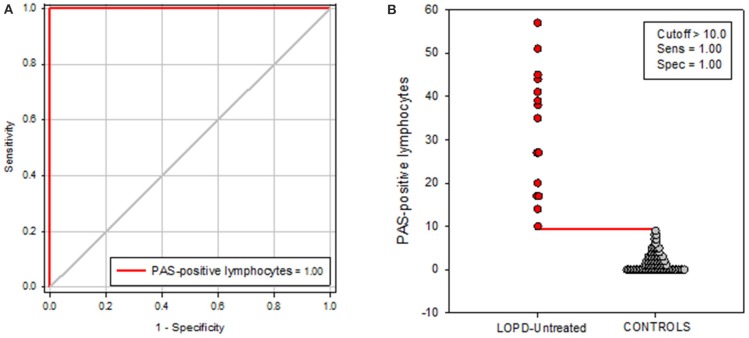
(A) Receiver operating characteristic (ROC) curve for distinguishing untreated LOPD patients vs. controls. The area under the receiver operating characteristic curve (AUC) demonstrates that the levels of PAS-positive lymphocytes assessed in serum are able to discriminate between untreated LOPD patients and controls, with an AUC of 1.00 (95% CI 1.00 to 1.00). (B) Levels of PAS-positive lymphocytes in untreated LOPD patients and in controls. The red horizontal line represents the optimal cutoff value for distinguishing between untreated LOPD patients and controls.